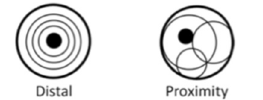
Figure 14. Increase Proximity and Decrease Distal Limitation.